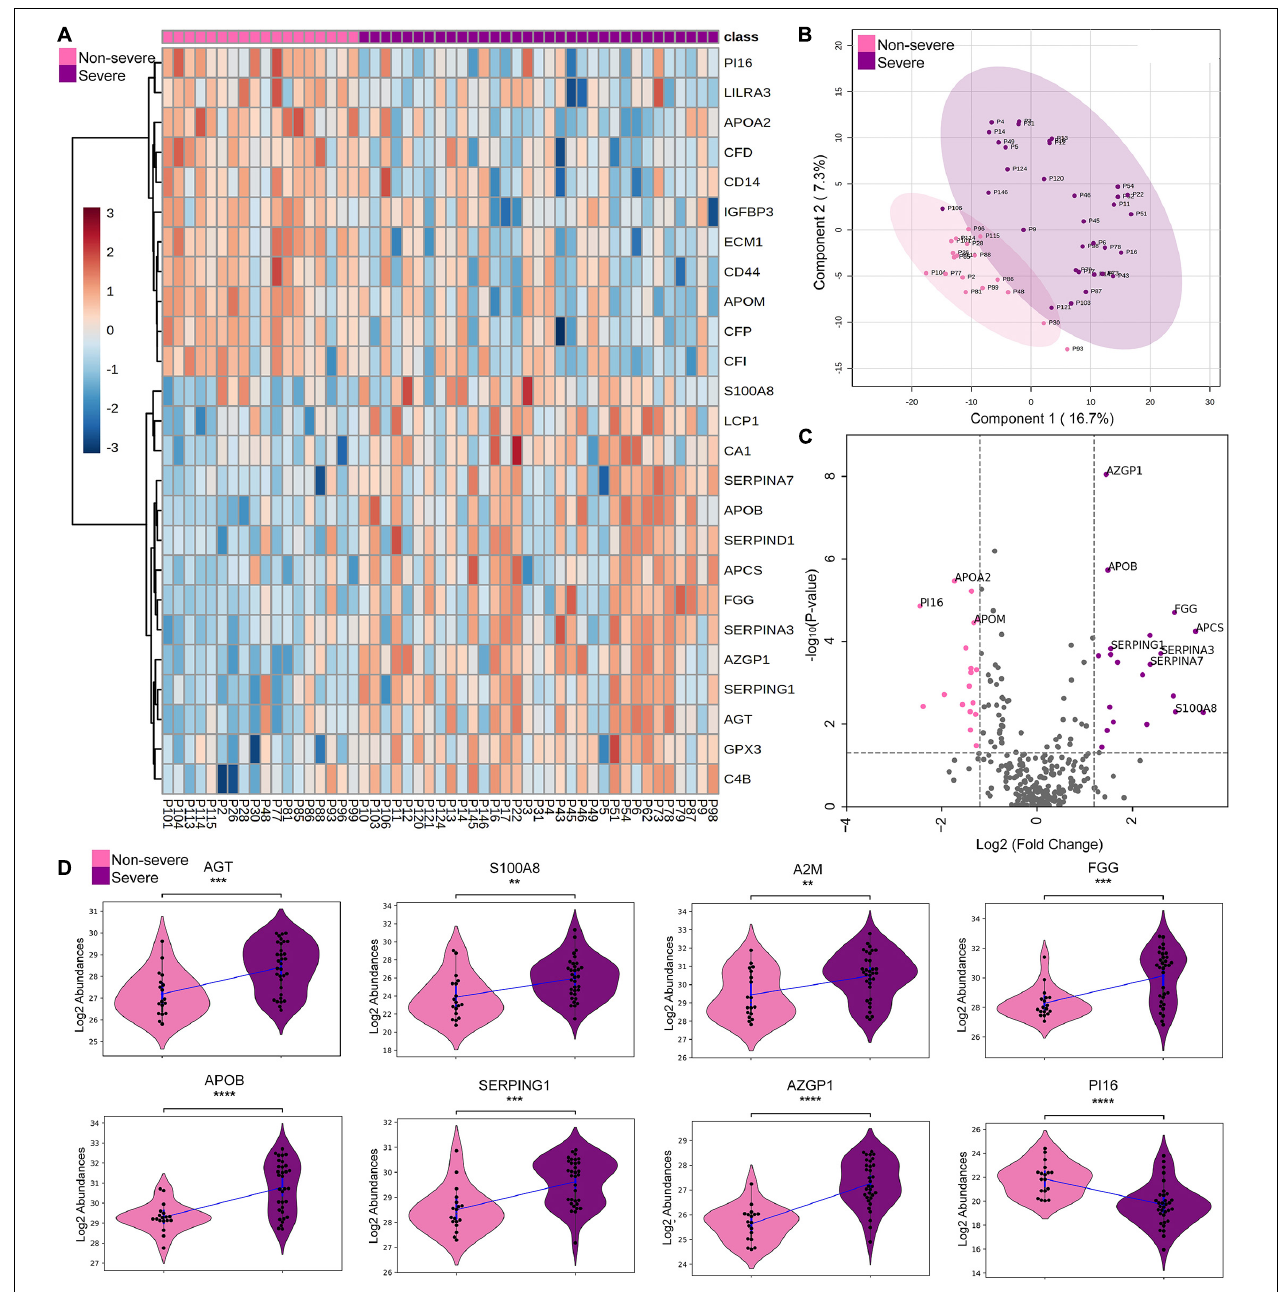
FIGURE 2 | Proteomic analysis of COVID-19 non-severe and COVID-19 severe patients. (A) Heatmap of top 25 differentially expressed proteins in COVID-19 severe when compared with the non-severe (B,C) depicts the PLS-DA clustering and significant differentially expressed proteins in the form of volcano plot in the COVID-19 severe when compared with the non-severe, respectively. (D) Violin plot showing a panel of 8 differentially expressed proteins in the severe vs. non-severe samples (**1.00e-03 < p ≤ 1.00e-02; ***1.00e-04 < p ≤ 1.00e-03; **** p ≤